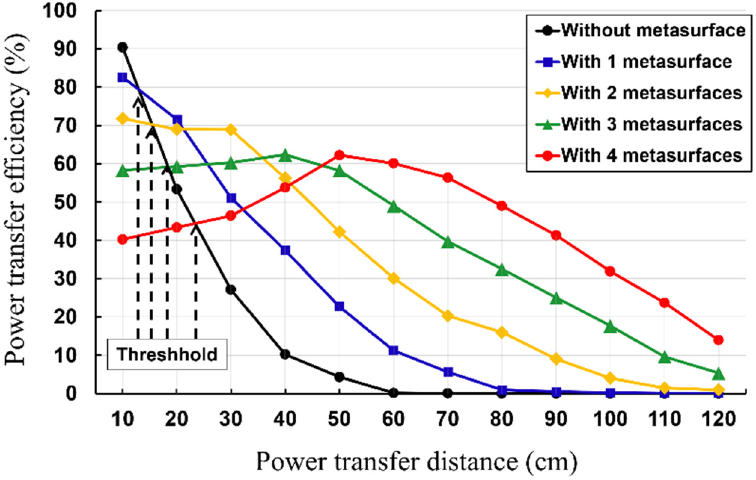
Figure 12. Measured PTE of the rollable WPT system without and with MS screens (up to